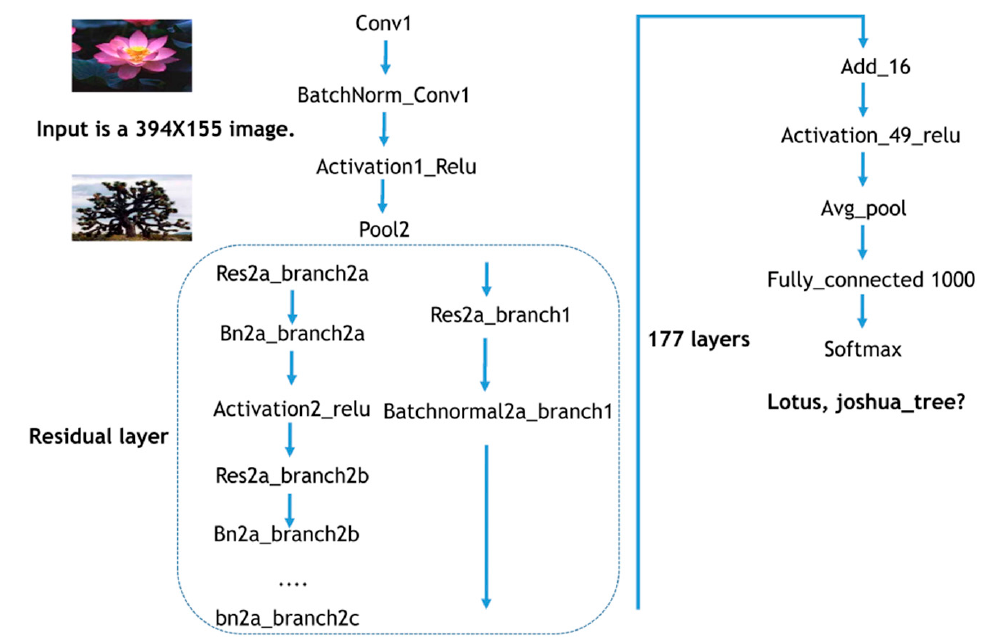
Figure 5. Residual convolution neural network architecture for image classification training using the Caltech 101 dataset. Res2s_branch2a represents the second stage and the second branch. The use of customized data for testing the image classification accuracy with and without FPM reconstruction was also conducted. For this, two customized training data were included, namely the flowers and apple pathology datasets. The flowers dataset included 4242 images with sub-categories of daisy, dandelion, flowers, rose, sunflower, and tulip. The number of images per category were balanced. The balanced apple pathology data had 3200 images. Blackrot, cedar rust, scab, and healthy apples were included. For the flowers dataset, SqueezeNet was used for the classification of different types of flowers shown in Figure 6. The SqueezeNet consists of repeated Squeeze and expansion neural network modules. The Squeeze and fire modules employ a 1 by 1 filter. The direct benefit of using a 1 by 1 convolution filter is that the network requires fewer parameters and more memory efficient. The subsequent downsampling (e.g., pool10) enables the larger activation map, thus is beneficial for maximizing the classification accuracy.